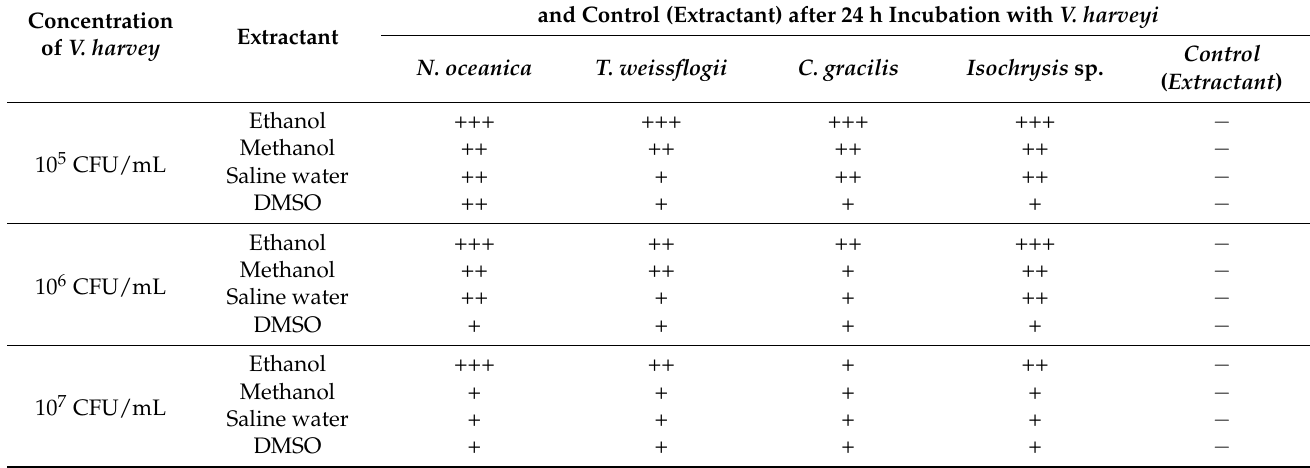
Table 1. Antibacterial susceptibility test of the microbial extract against V. harveyi . Diameter of the Inhibition Zone (D) in mm by Marine Microalgae Extract (10 6 Cell/mL) and Control (Extractant) after 24 h Incubation with V. harveyi Concentration Extractant of V. harvey